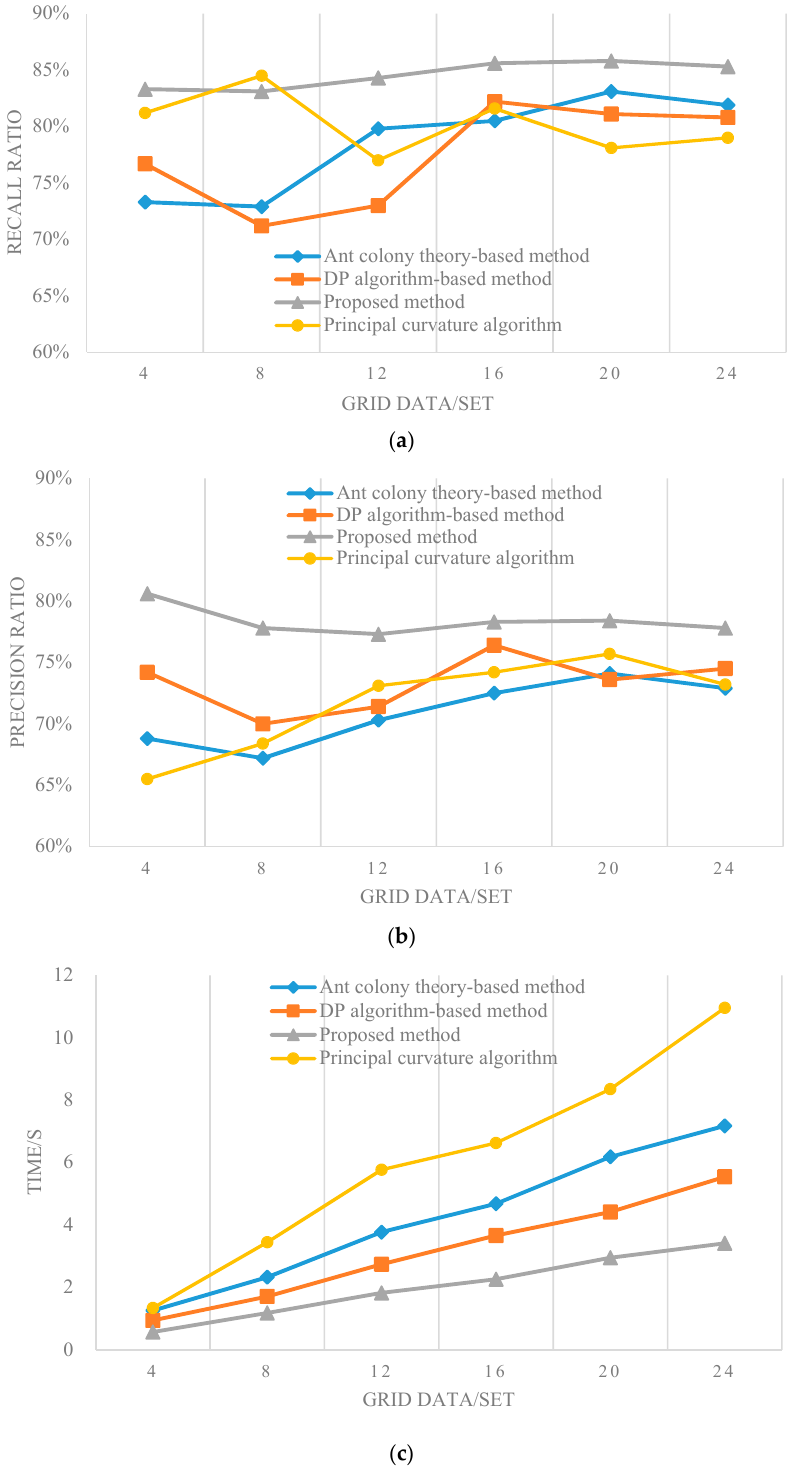
Figure 9. Comparison results of three different automatic analysis methods of trough lines in terms of recall ratio comparison ( a ), precision ratio comparison ( b ), and processing time comparison ( c ).